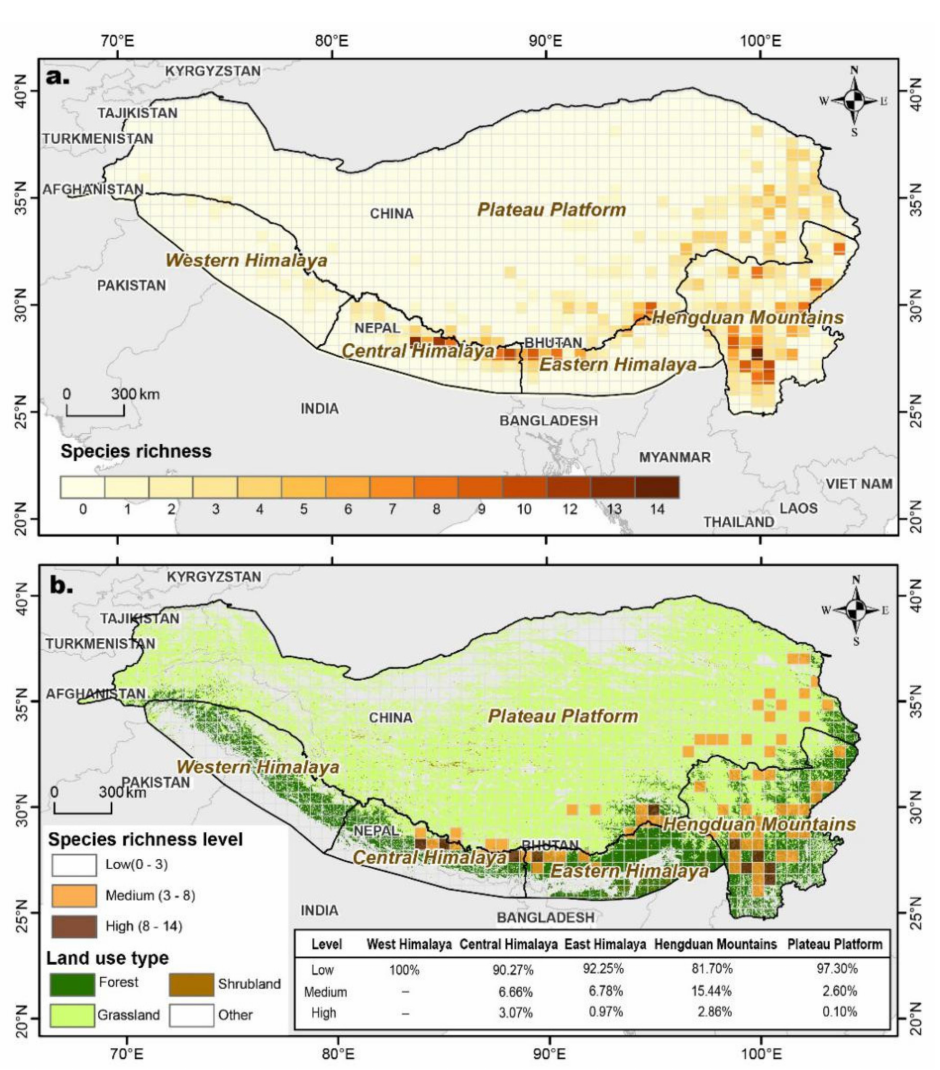
Figure 6. Spatial distribution of species richness of Meconopsis per 50 km × 50 km grid cell. ( a ) species richness distribution of each grid in the study area; ( b ) the distribution of species richness of Meconopsis in different vegetation.